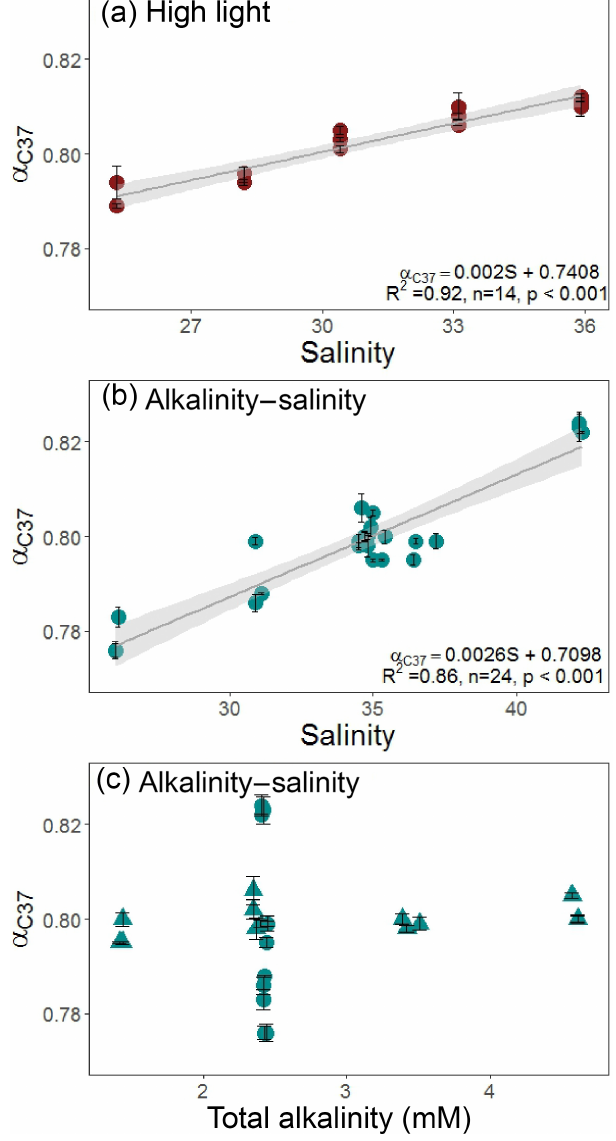
Figure 2. Hydrogen isotope fractionation factor α C against salinity for the (a) high-light experiment and (b) alkalinity– salinity experiment. The grey shading represents the 95% confi- dence interval for the linear regression model fir to the dataset. Panel (c) shows hydrogen isotope fractionation factor α C total alkalinity for the alkalinity–salinity experiment. The triangles represent the set of batch cultures grown at constant salinity (35) over a range of alkalinity (1.4–4.6), and the circles represent the batch cultures grown at constant alkalinity (2.4) over a range of salinity